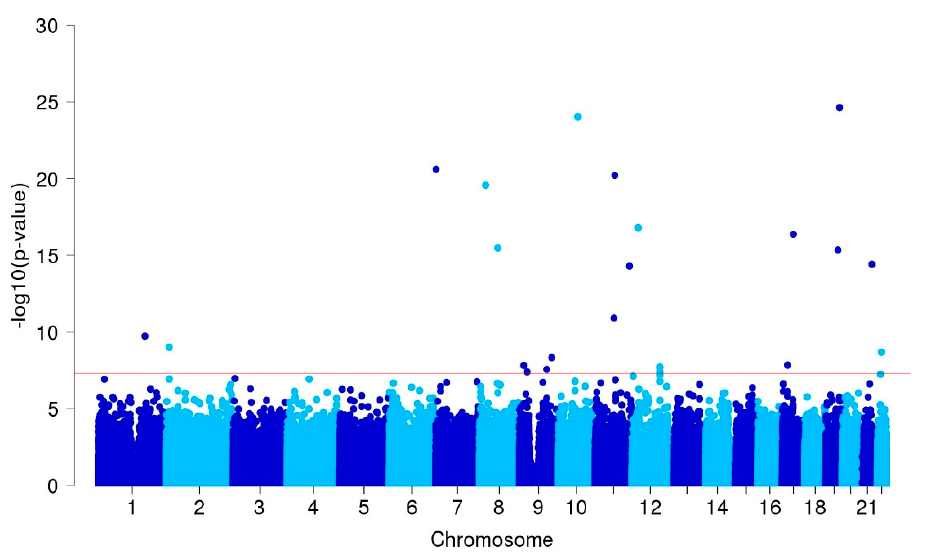
Figure 1. Manhattan plot of a genome-wide association study in 250 patients with intracranial aneurysms and 294 controls after adjusting for age, sex, hypertension, diabetes, hyperlipidemia, cigarette smoking, and four principal components. The red sub-line indicates the genome-wide significance threshold ( P = 5 × 10 − 8 ).